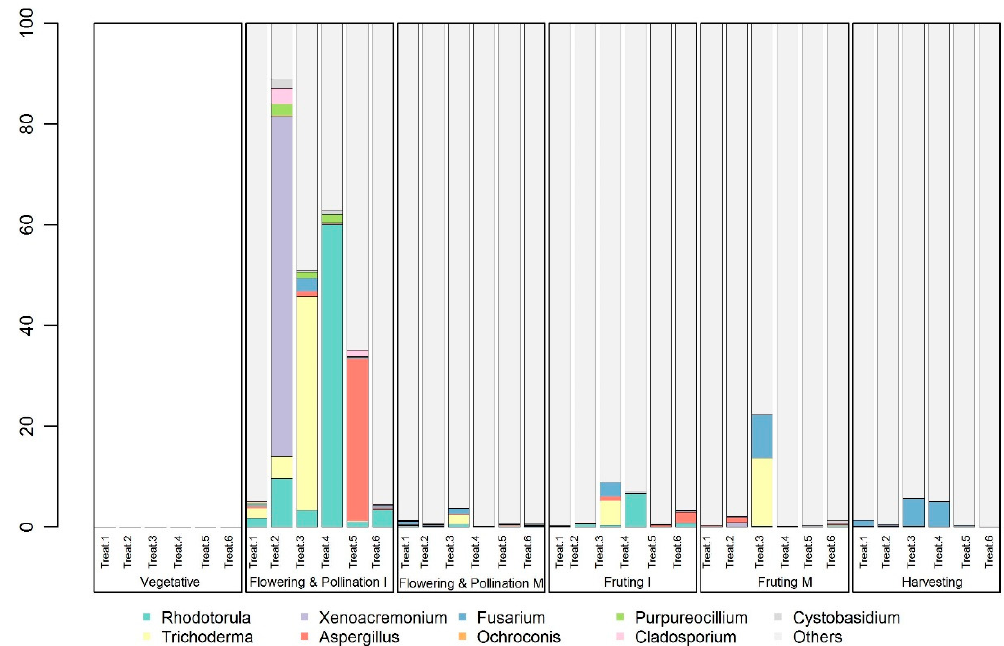
Figure 6. Change in dominant rhizosphere fungal taxa at the genus level across different nutrient treatments and melon growth stages.